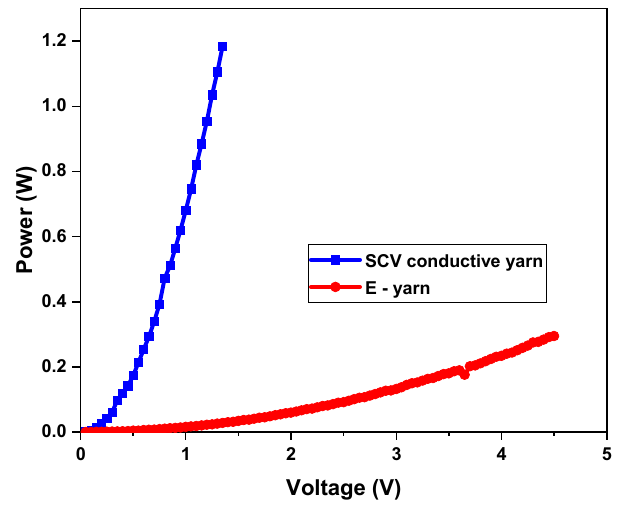
Figure 14. Power depicted in SCV conductive yarn and E-yarn.